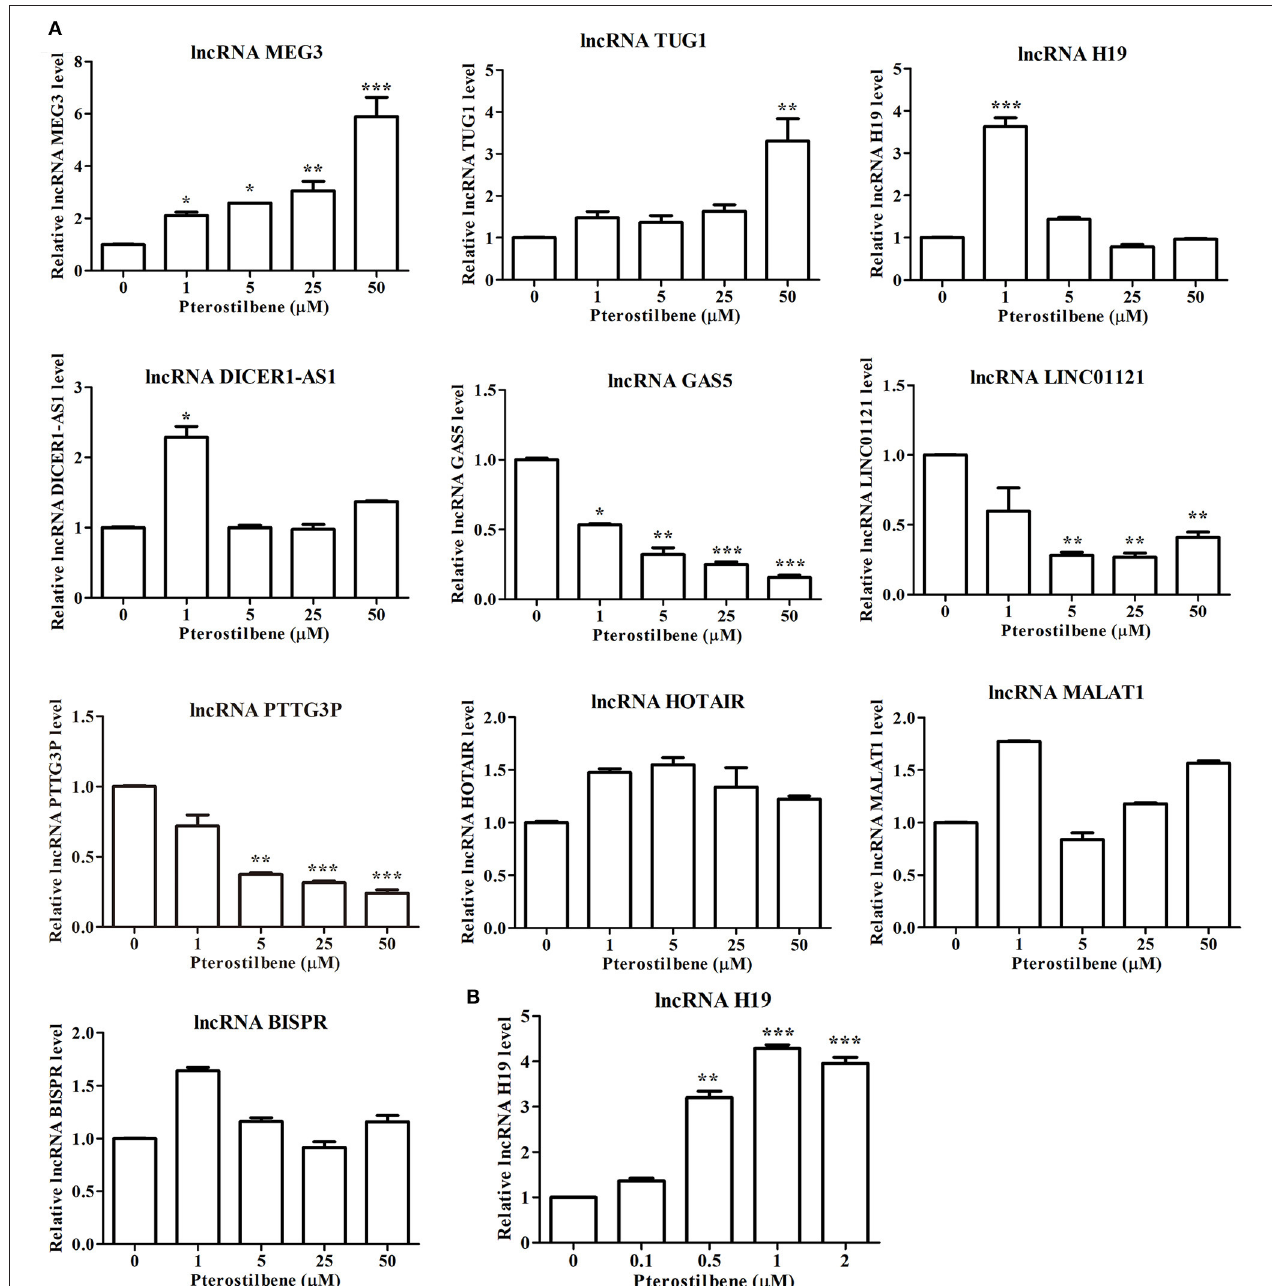
FIGURE 11 | Pterostilbene influenced the expression of lncRNAs. (A) Cells were treated with pterostilbene at different concentrations (0, 1, 5, 25, and 50 µ M) for 24h with gene expression determined by qRT-PCR. (B) Expression of the lncRNA H19 in cells treated with 0, 0.1, 0.5, 1, and 2 µ M pterostilbene for 24h as determined by qRT-PCR. Reported values are mean ± SEM. * p < 0.05, ** p < 0.01 and *** p < 0.001, indicate significant differences compared with the control group.